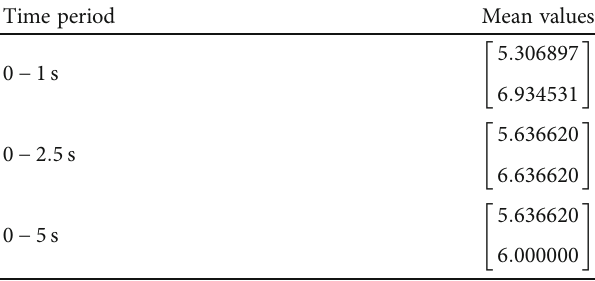
Table 4: Mean values of the pulsating wind velocity function. Time